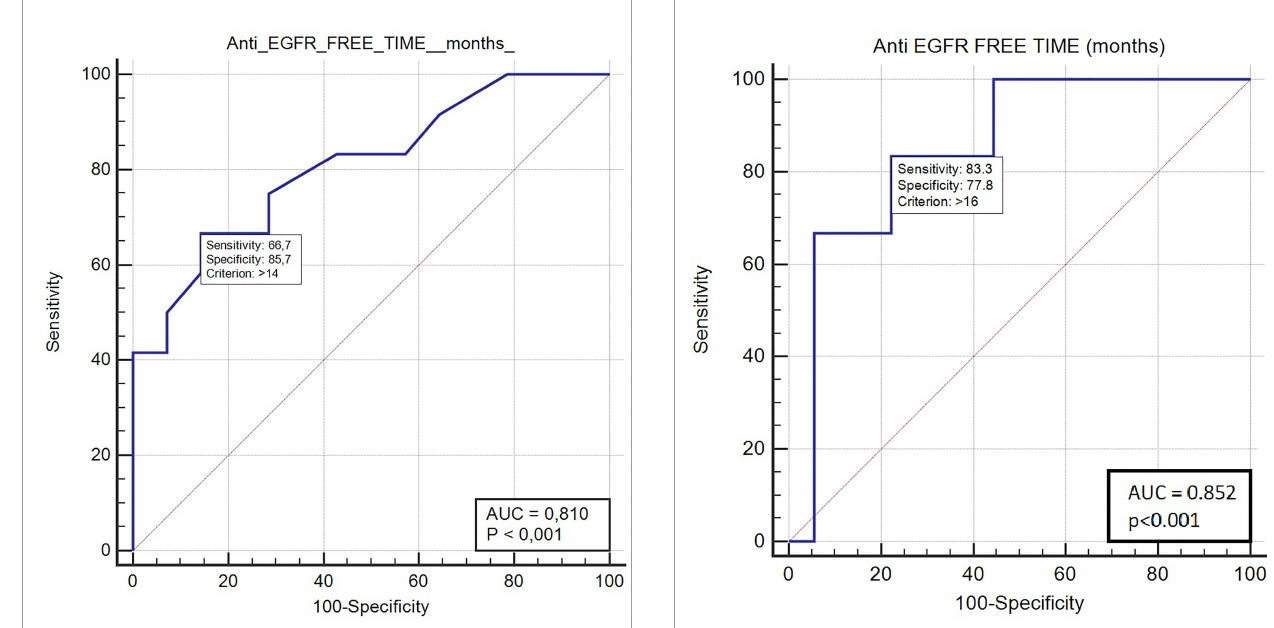
TABLE 2 | Clinical outcome results according to several clinical factors.